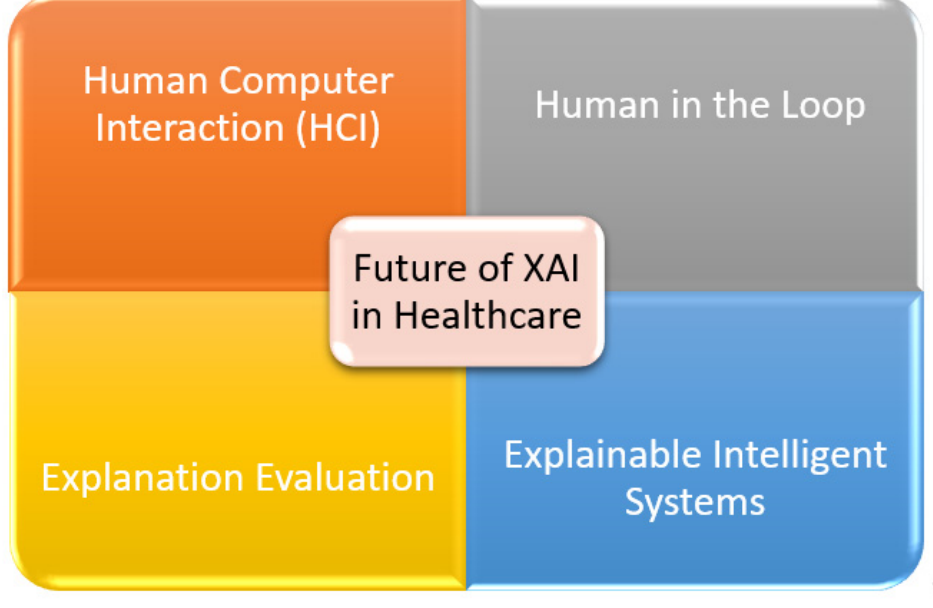
Figure 5. XAI in